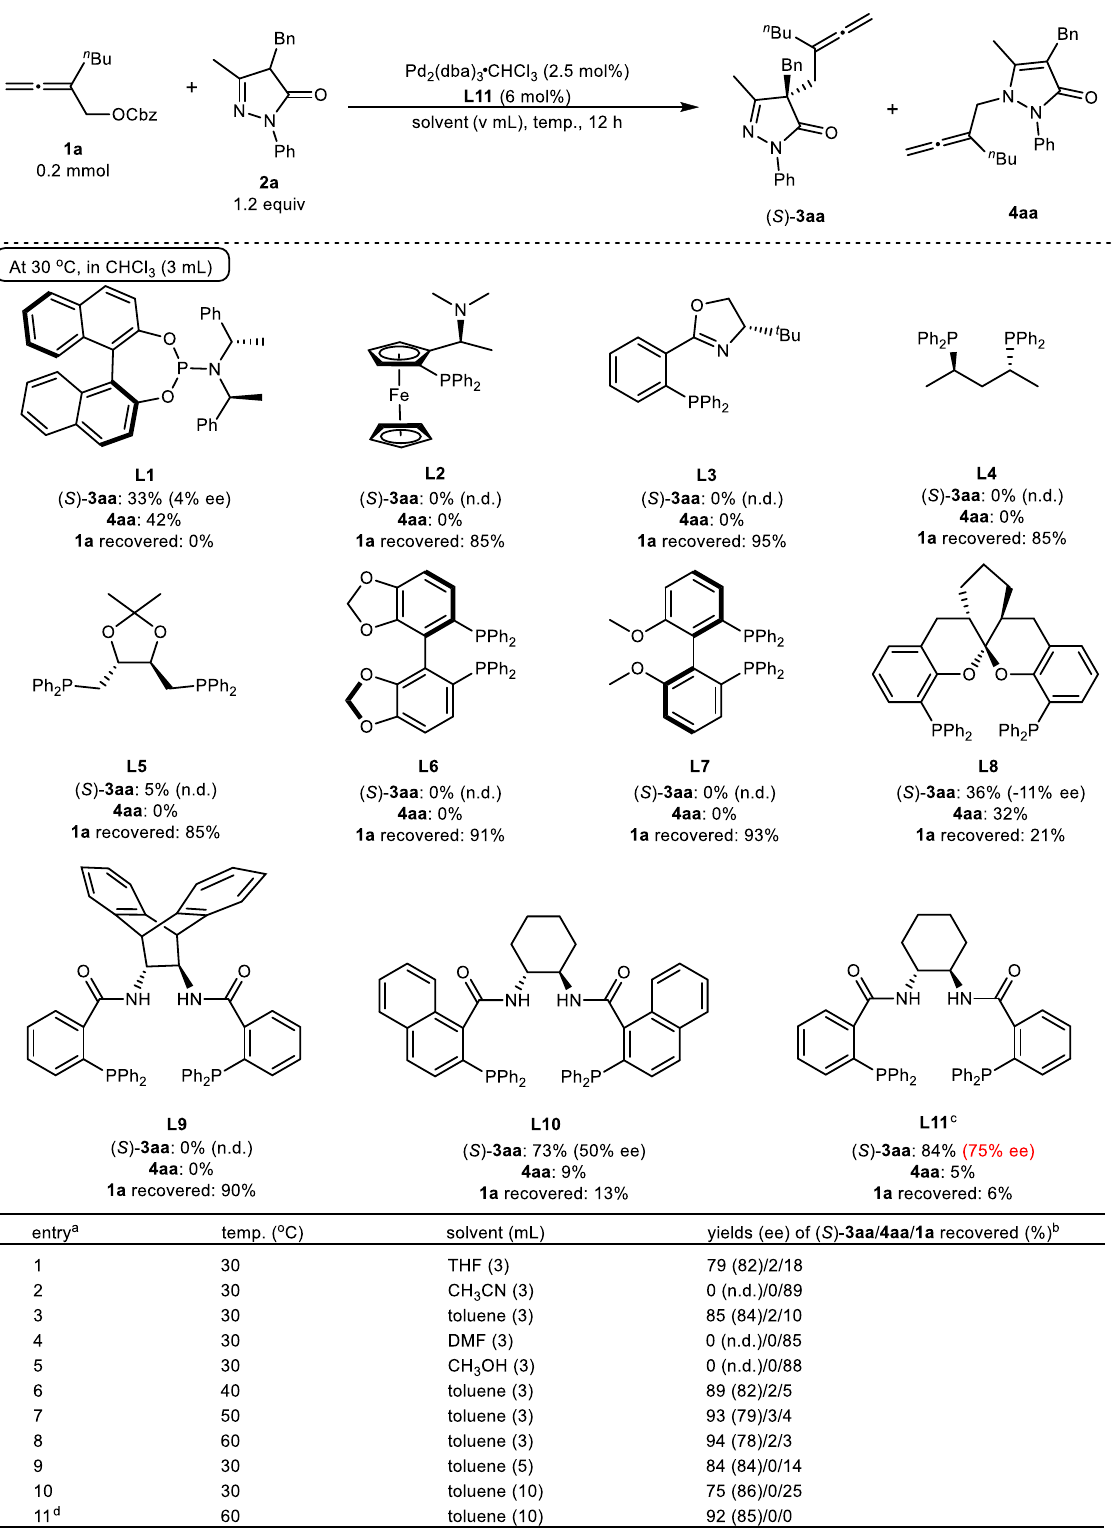
Fig. 2 The selected data of optimization with some commercially available chiral ligands. a Reaction conditions: 1a (0.2 mmol), 2a (1.2 equiv), Pd 2 (dba) 3 (cid:129) CHCl 3 (2.5 mol%), and L1 - 4 (12 mol%) or L5 - 11 (6 mol%) unless otherwise noted. b The yields of ( S )- 3aa and 4aa as well as the recovery of 1a were determined by the 1 H NMR analysis of the crude product using mesitylene as the internal standard and the ee of isolated ( S )- 3aa was determined by chiral HPLC. c The reaction time was 4 h. d L11 (5 mol%) was used and the reaction time was 3 h. Cbz benzyloxycarbonyl, THF tetrahydrofuran, DMF N , N - dimethylformamide, n.d. not